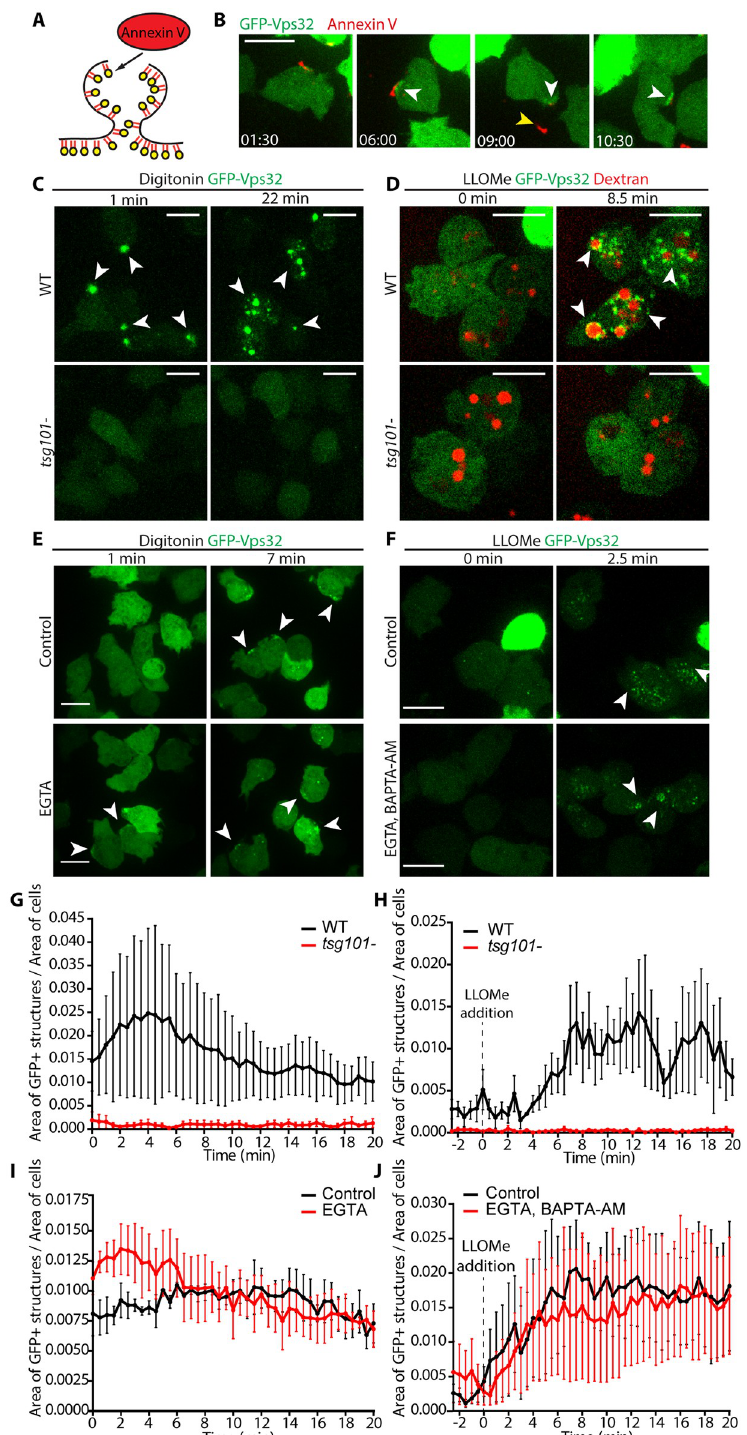
Fig 5. Mechanistic characterization of ESCRT-III and autophagy recruitment and repair of membrane damage. (A) Schematic representation of the experiment shown in B. Annexin V binds to PS exposed upon plasma membrane disruption. (B) D . discoideum were incubated with Annexin V Alexa Fluor 594 conjugate in the presence of Ca 2+ and then treated with digitonin and monitored by time-lapse imaging (see also S5 Movie). GFP-Vps32 structures (in green) appeared in close proximity of Annexin V-positive structures (in red, white arrows). At later times, the Annexin